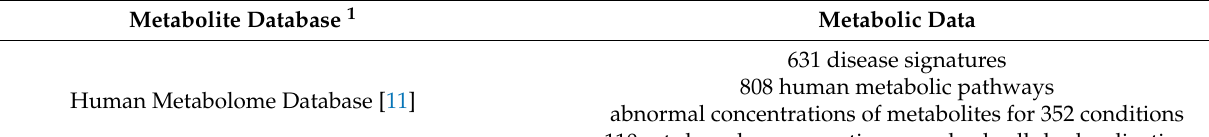
Table 1. Data presented in metabolite